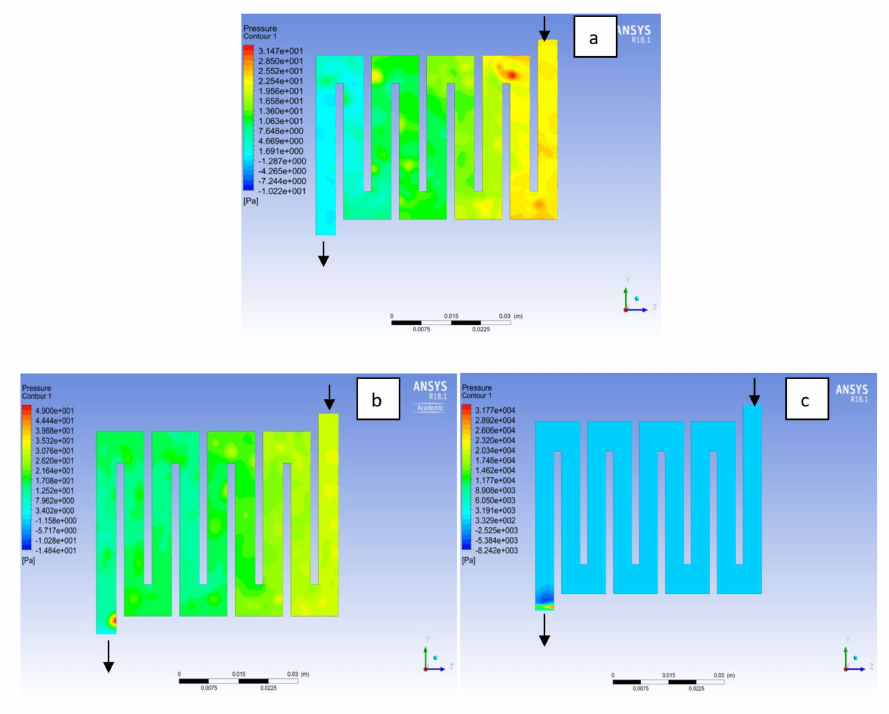
Figure 13. Pressure distribution at the cathode region (GDL/CL) for each material with temperature 323 K at 2.0 bar: ( a ) Aluminum, ( b ) Copper, ( c )